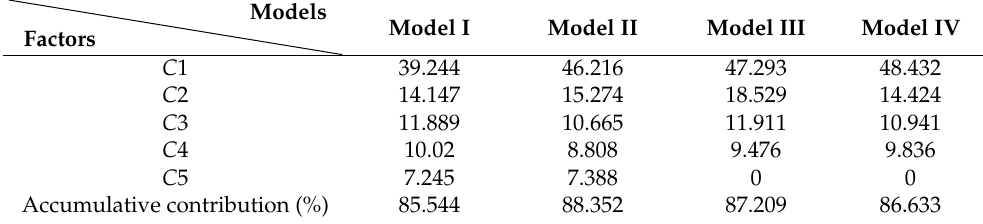
Table 10. Contribution rates of common factors in four models.